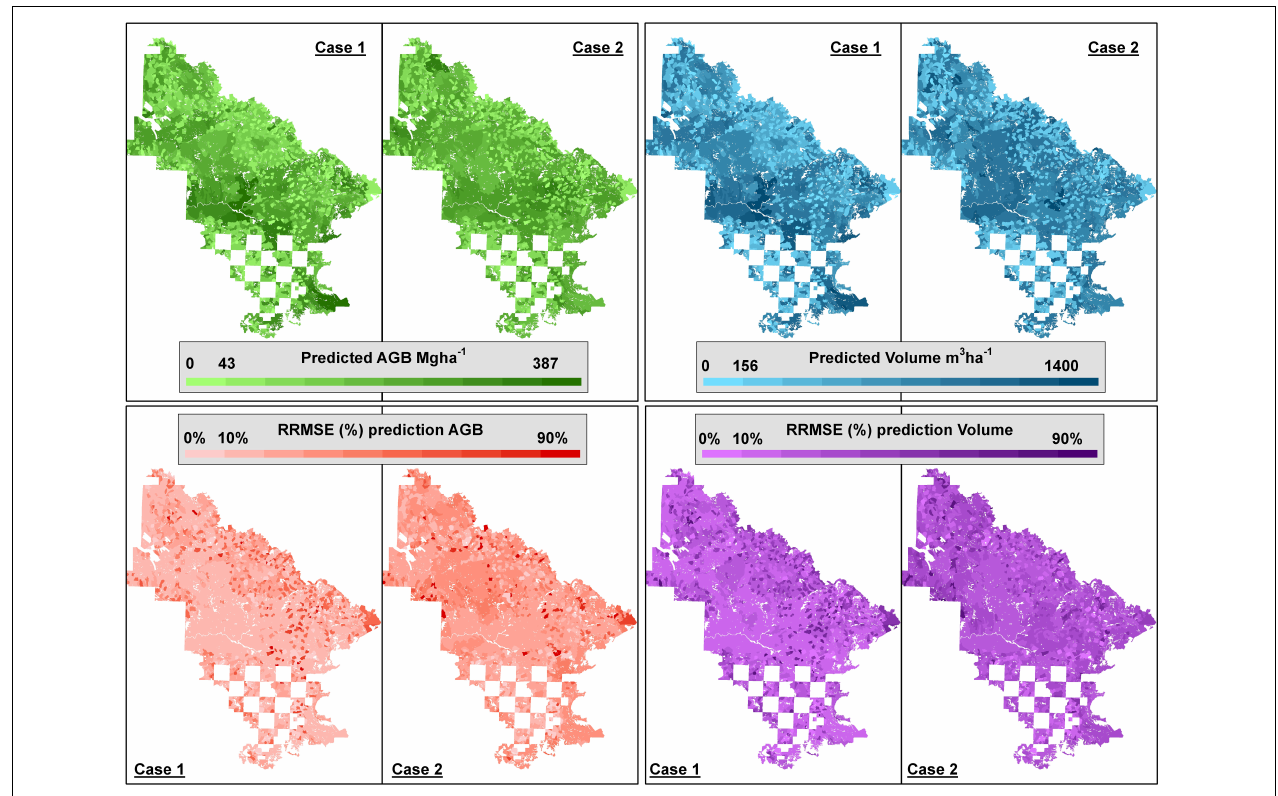
FIGURE 5 | Stand-level predictions of above-ground biomass (AGB) and volume (V) for all stands in the study area (sampled and unsampled) and stand-level RMSE based on the FH models for Case 1 and Case